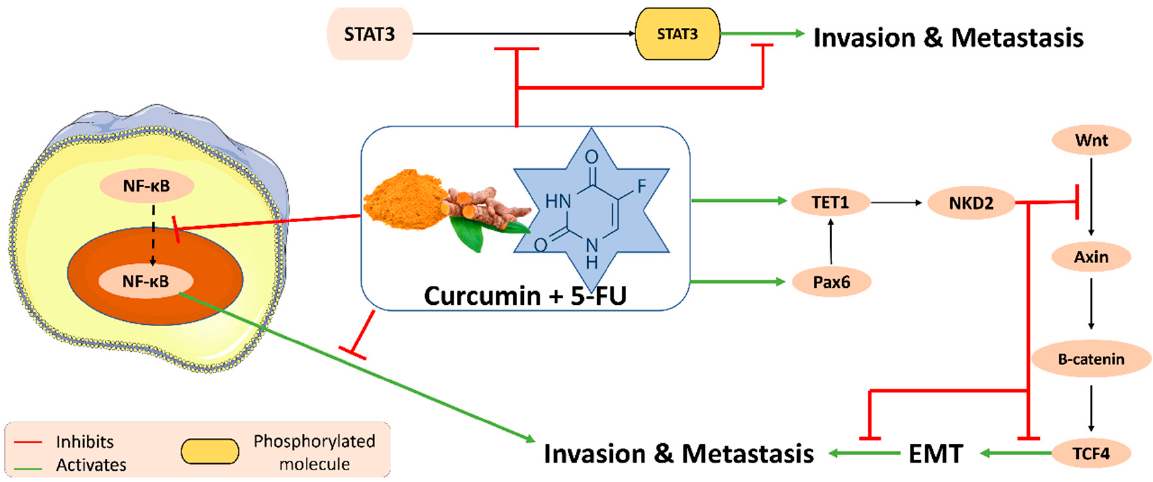
Figure 4. Molecular pathways underlying the anti-metastatic and anti-invasive properties of curcumin in combination with 5-fluorouracil (5-FU).